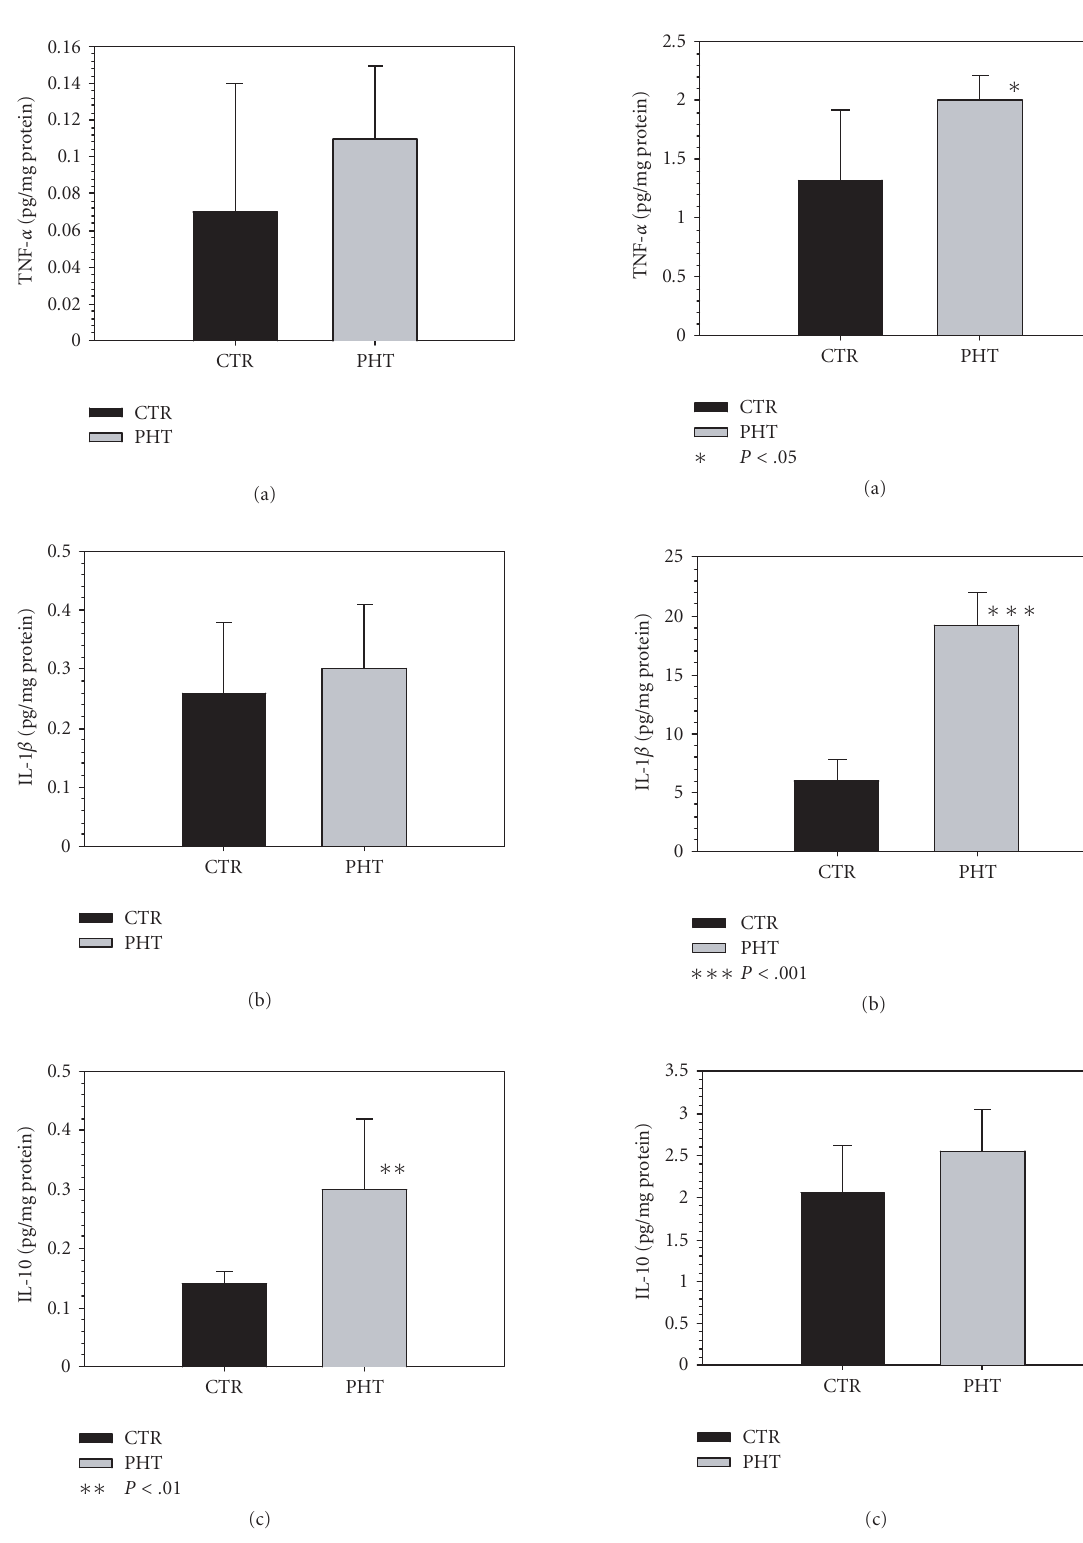
Figure 3. Concentrations of (a) TNF- α , (b) IL-1 β , and (c) IL-10 in liver of control rats (Group I) and in rats with portal hyper- tension (PHT) by triple stenosing ligation of portal vein (TSLP) (Group IIb) after 28 days of